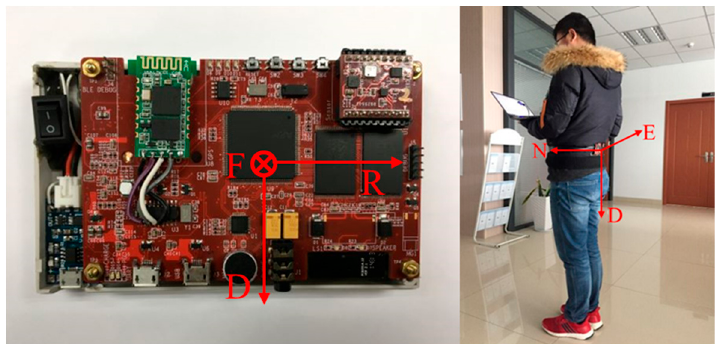
Table 2. The performance parameters of the VT-IMUs.